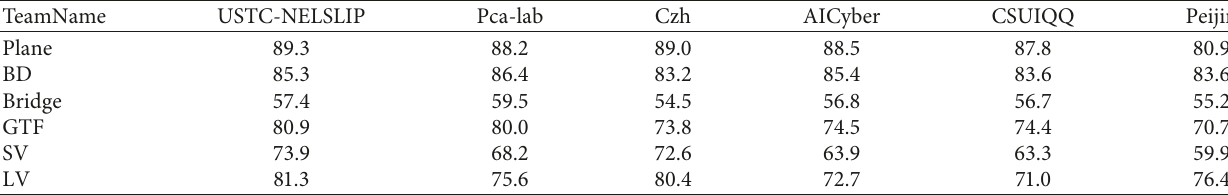
Table 4: Task 1-DOAI2019 rotating frame ranking.